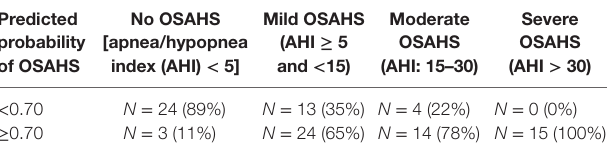
Table 3 | Comparison between the predicted probability of obstructive sleep apnea–hypopnea syndrome (OSAHS) (calculated by multivariate logistic model which includes age, BMI, HLLV, NC) and the actual prevalence of OSAHS.